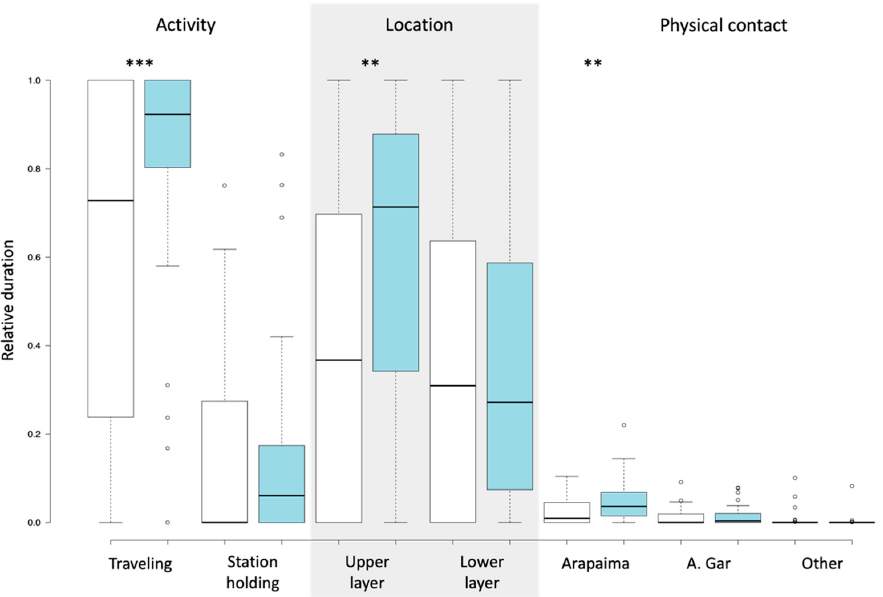
Figure 2. The relative duration (observed duration/fish presence in the exhibit tank) of the seven monitored state behaviours (behaviour where duration was documented); during the test (blue) and baseline (white) conditions. Boxplots represent the median and interquartile range (IQR) with whiskers indicating the top and bottom 5% of occurrences and outliers are represented by the circles. Significant change between baseline and test conditions is marked with asterisks (** p > 0.01, *** p > 0.001). Table 3. Results of observed duration likelihood ratio test (df = 1) comparing the two linear mixed models, one with and the other without the fixed effect (effect of the use of the green laser pointer).